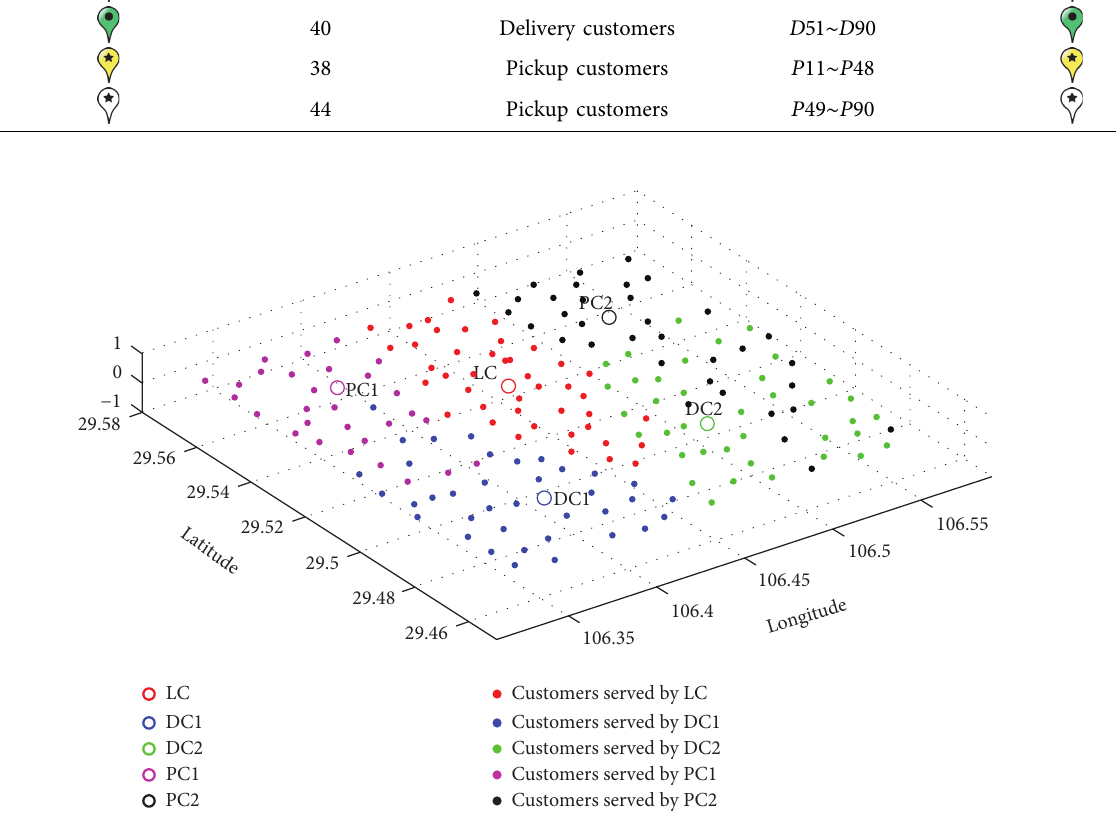
Figure 7: Results of customer clustering. Table 8: Comparative results of the costs, the number of trucks, and the number of